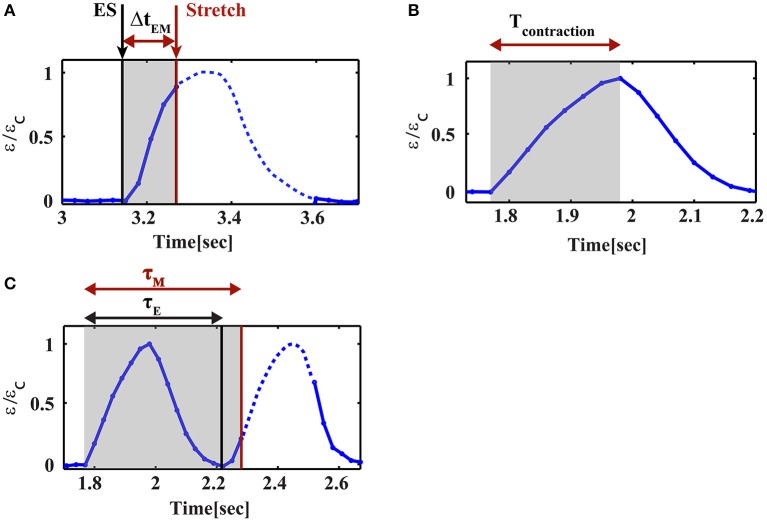
Parameter definitions for cyclic stretch and cell contraction. (A) ΔtEM is the time delay between the initiation of stretch and the electrical stimulus, (B) Tcontraction is the duration of the contraction phase of the beating cycle, (C) τM is the phase shift of the contraction relative to the mechanical stretch and τE is the phase shift of the contraction relative to the electrical stimulation. The black lines correspond to the electrical stimulus and the red lines mark the initiation of mechanical stretch.